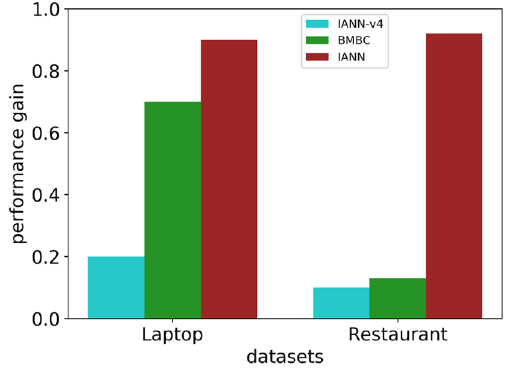
Fig. 9 The performance gain of different models with multilayer archi- tecture in the laptop dataset and restaurant dataset